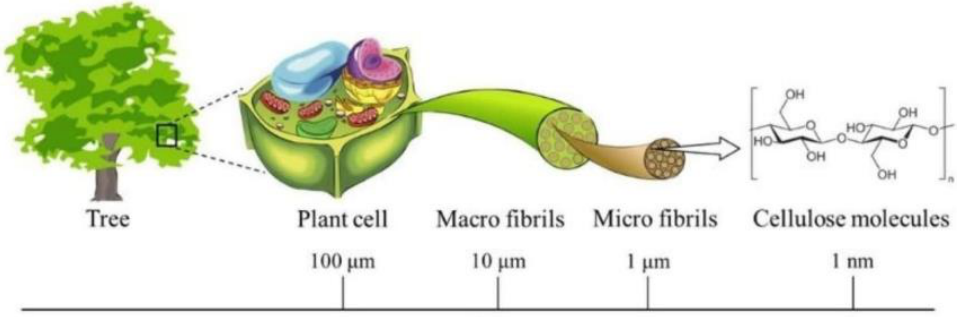
Figure 1. The hierarchical structure of plant-based cellulose at different scale levels [33].